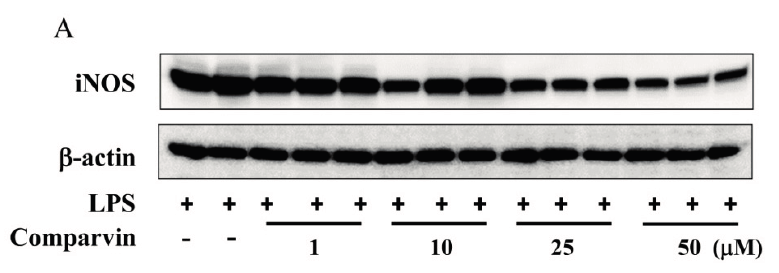
Figure 3. Effect of comaparvin on the expression of the pro-inflammatory protein iNOS, in LPS-stimulated macrophage cells. ( A ) Western blot bands corresponding to the effects of comaparvin on iNOS and β -actin expression in LPS-stimulated macrophage cells; ( B ) The relative intensity of expression of iNOS protein in the LPS-alone group was set to 100%, and β -actin was used to verify that equivalent amounts of protein were loaded in each lane. Comaparvin significantly inhibited iNOS protein expression in LPS-stimulated macrophage cells. Data are the mean ± SEM values of 4 independent experiments. * p < 0.05, significant difference compared with the LPS-alone